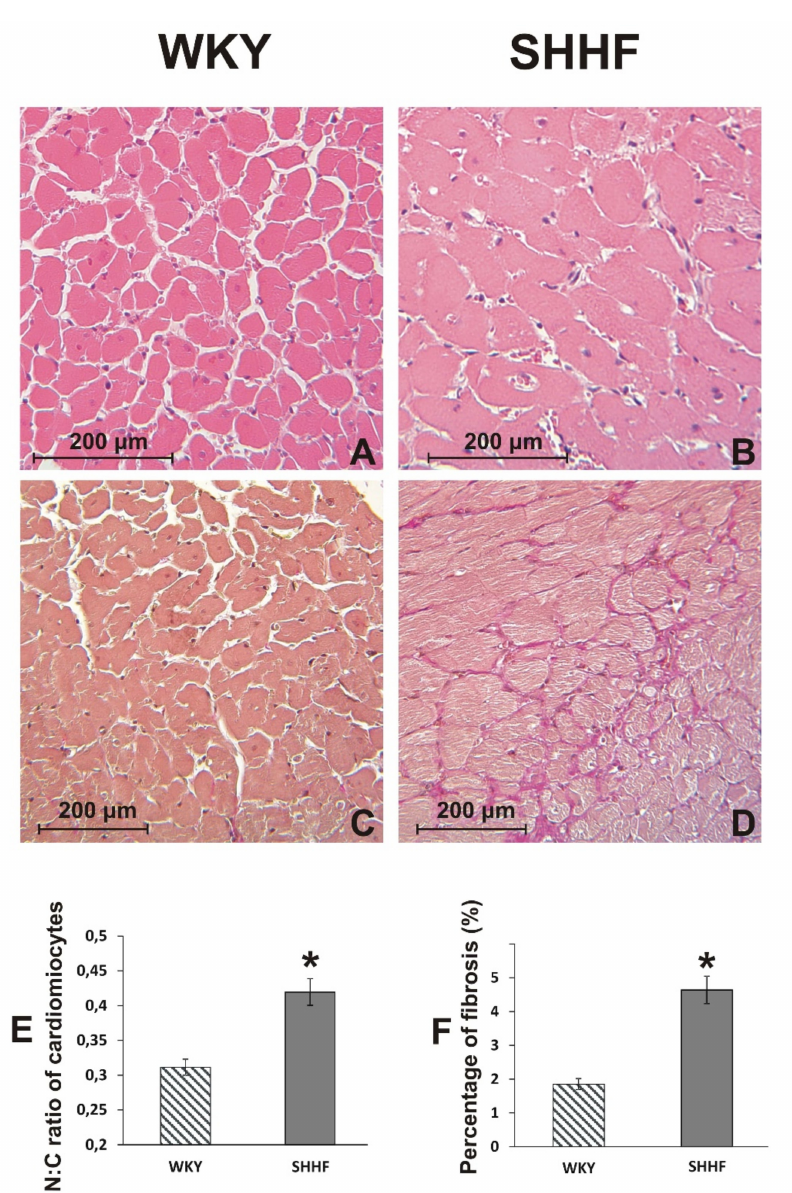
Figure 1. Histological image of the heart. ( A , B ) Cross section of cardiac muscle fibers stained with hematoxylin-eosin stain and viewed at a x10 magnification (lens). ( C , D ) Cross section of cardiac muscle fibers stained with van Gieson stain (for connective tissue fibres) and viewed at a × 10 magnification (objective lens). ( E ) The nuclear-cytoplasmic ratio of cardiomyocytes in WKY ( n = 5) and SHHF ( n = 5). ( F ) Percentage of myocardial fibrosis in WKY ( n = 5) and SHHF ( n = 5). Means ± SE, * p < 0.05 by t